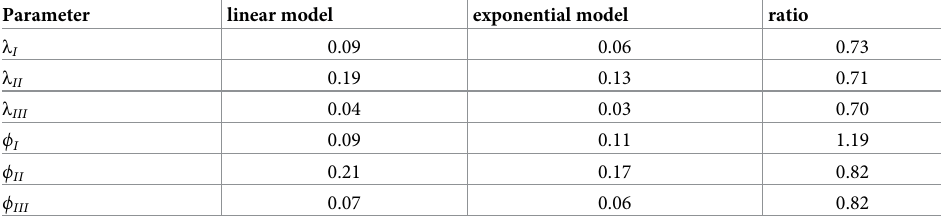
Table 4. The parameter estimates for lymphatic spread of tongue cancer.